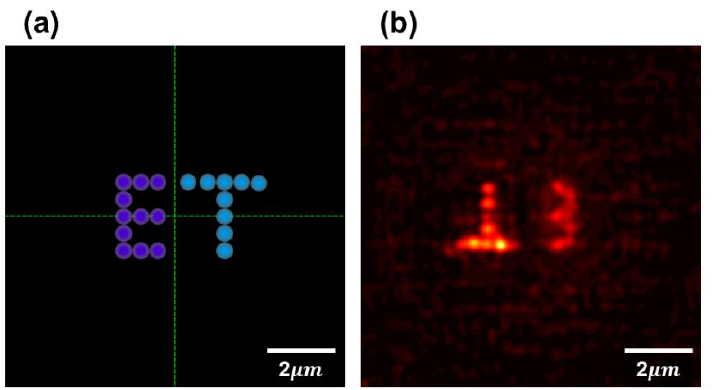
Figure 8. Imaging of multiple incoherent point light sources at different wavelengths. ( a ) The designed structures of combined characters composed of multiple incoherent point light sources are placed on an object plane at Z obj = 13.5 μm, while the illumination wavelengths for the characters E and T are 445 nm and 484 nm, respectively. ( b ) displays corresponding imaged pattern to the combined characters on the same image plane at Z img = 10.2